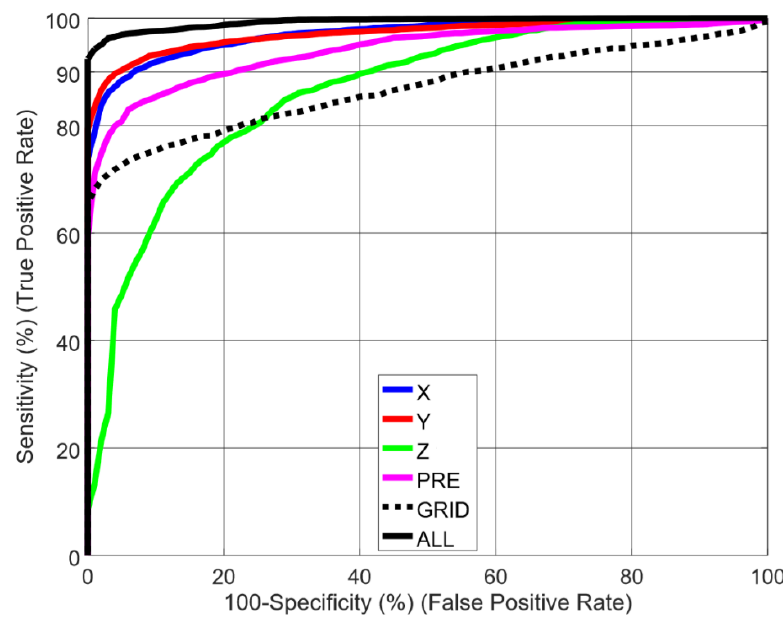
Figure 5. Sensitivity vs. specificity curves for every signal independently: X, Y, and Z coordinates, pressure (PRE), and grid angle (GRID) and including all the signals together (ALL).